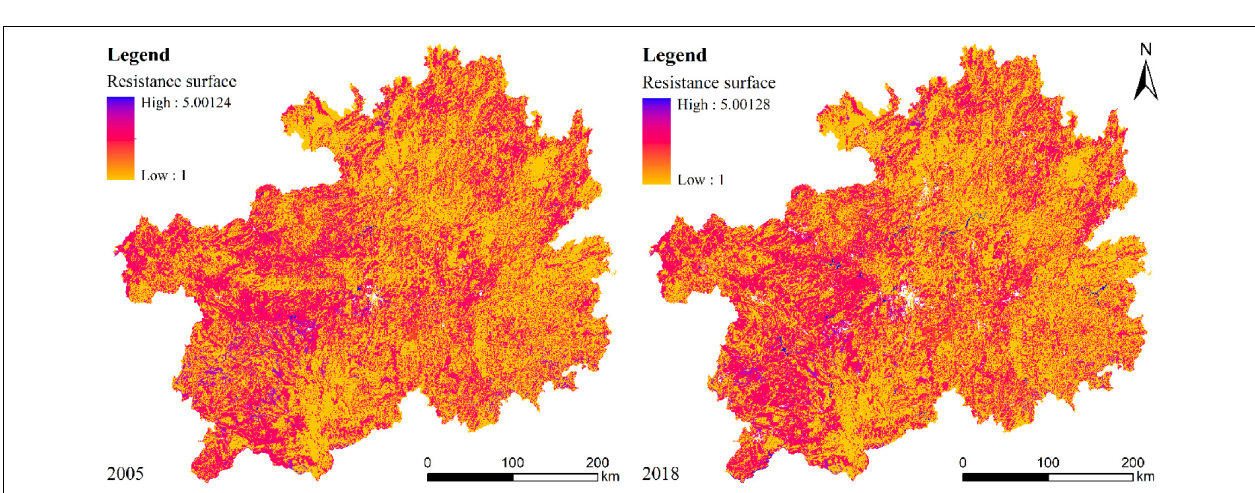
Regions with slightly improved vegetation coverage showed a dispersive distribution. Regions with stable or slightly degraded vegetation coverage were distributed mostly in Central